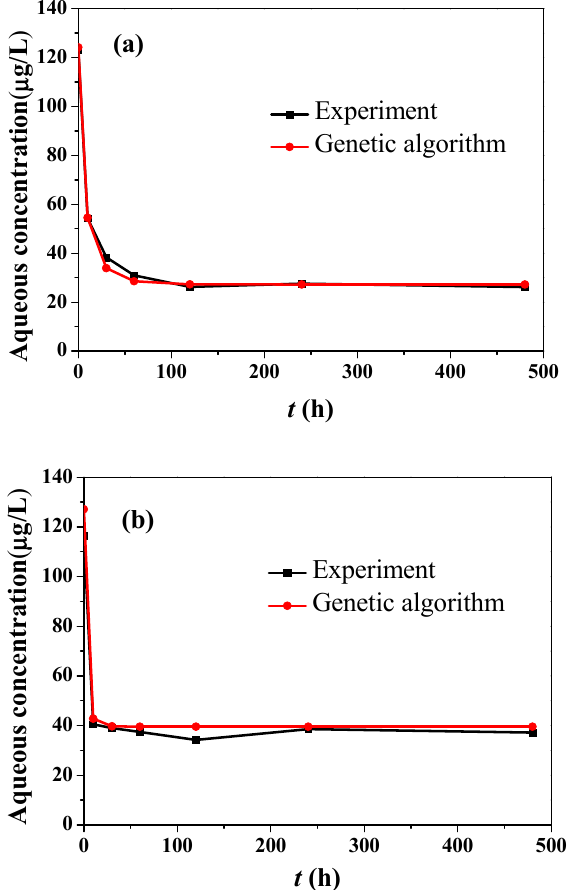
Figure 8. Temporal evolutions of the ion concentrations of ( a ) Eu(III) and ( b ) La(III) in the aqueous solution.